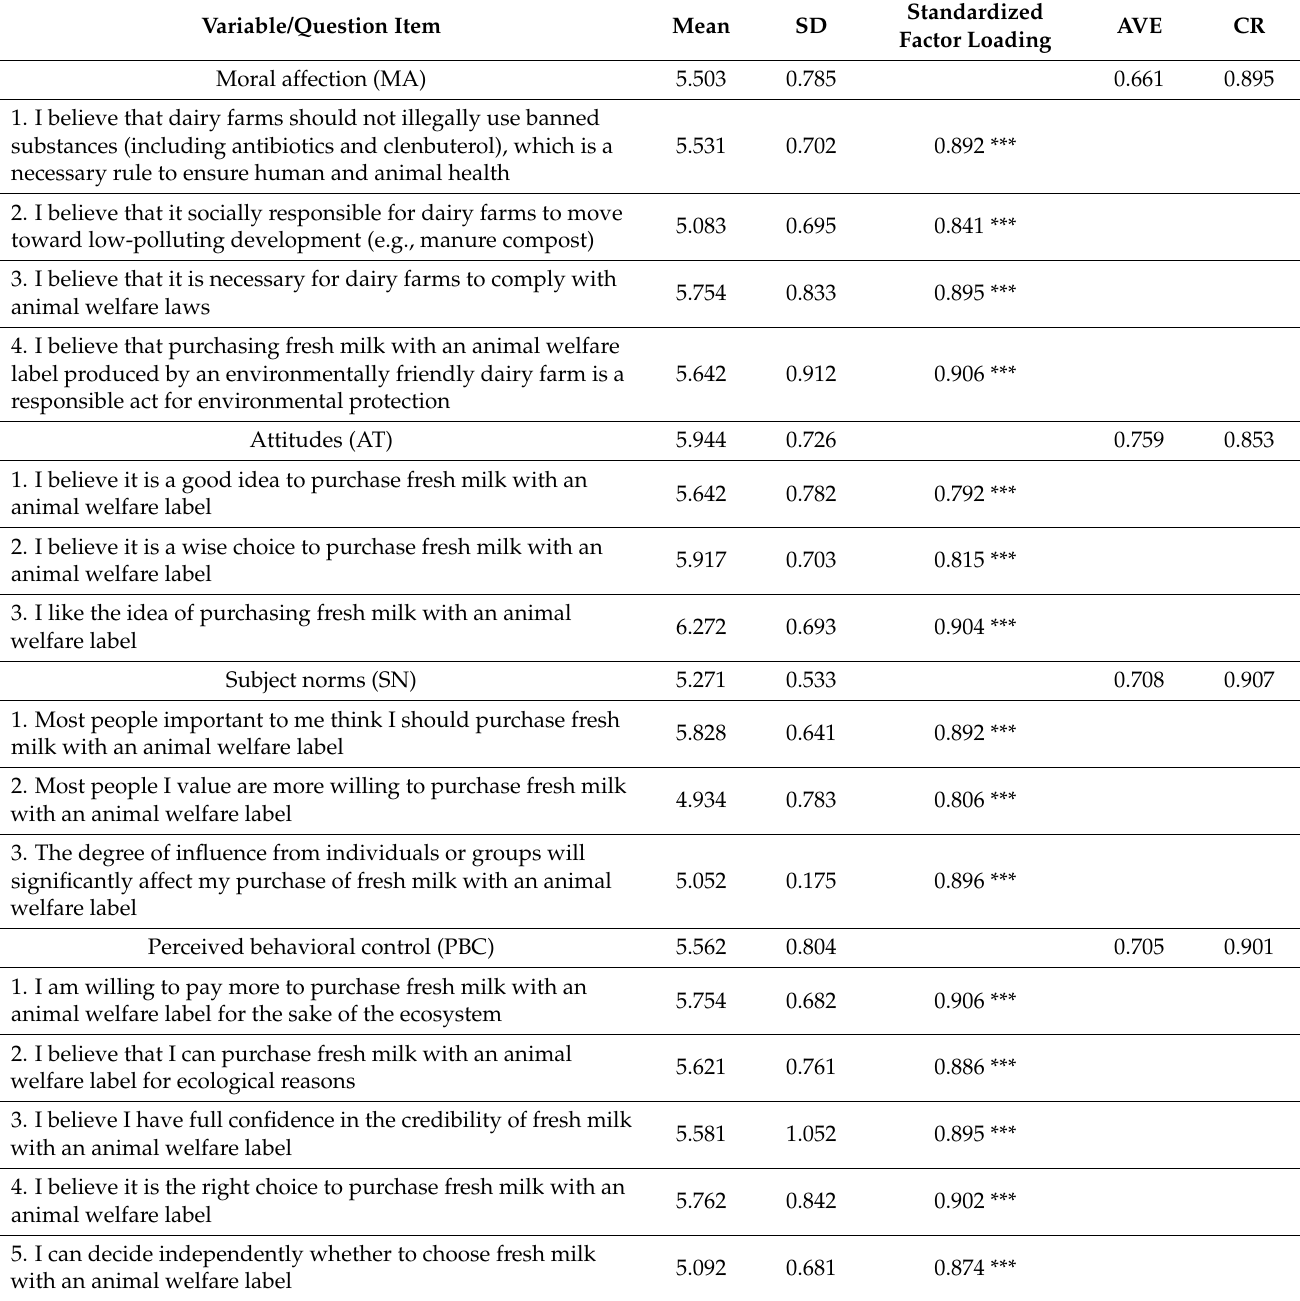
Table 1. Summary of reliability test on measurement